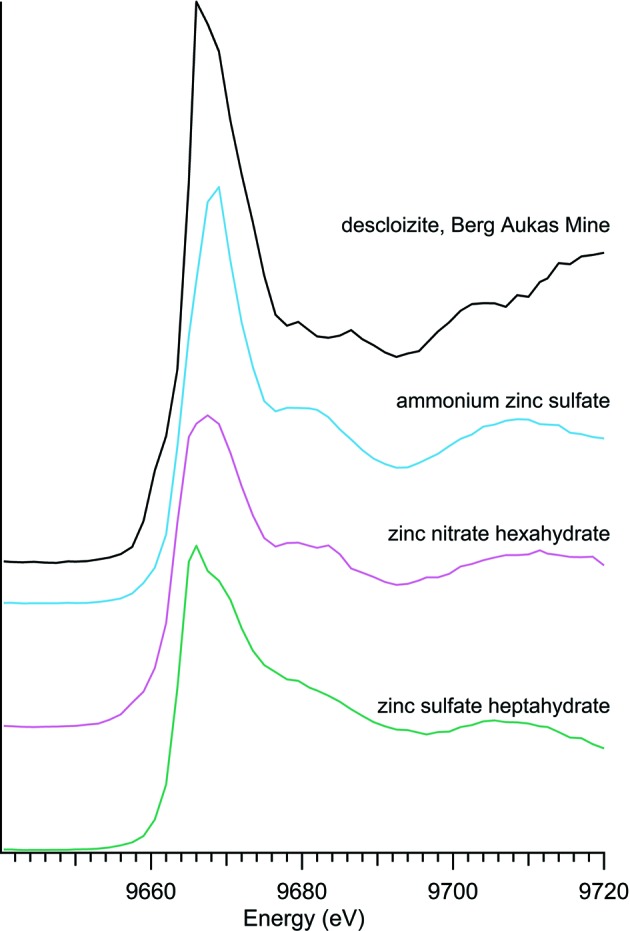
Zinc oxyanion spectra.